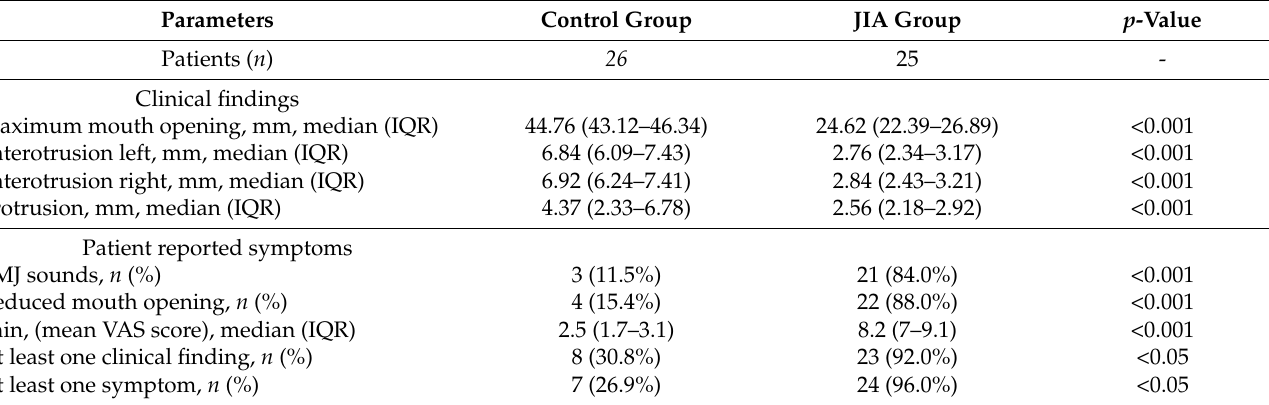
Table 2. Clinical findings and reported symptoms in the two groups.